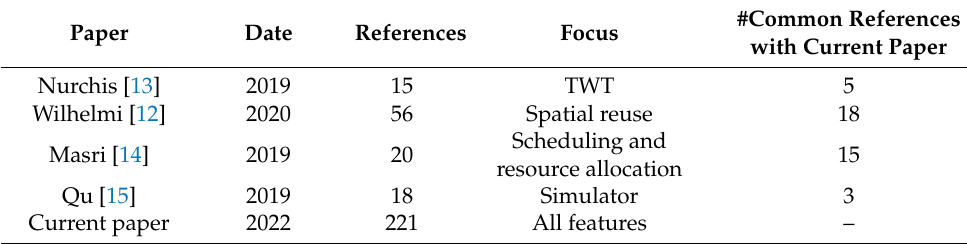
Table 3. Surveys on Wi-Fi 6.